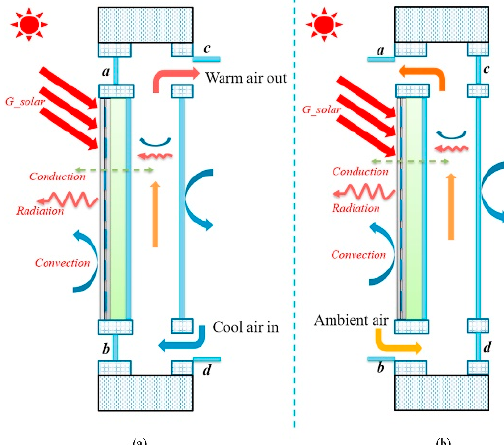
Figure 19. Energy flow and operating modes of the PCM-PV multi-layer ventilated glazing system in ( a ) winter mode and ( b ) summer mode, listed as vents a, b, c, and d [61]. Table 5. Summary of PCM/PV-incorporated multi-layer